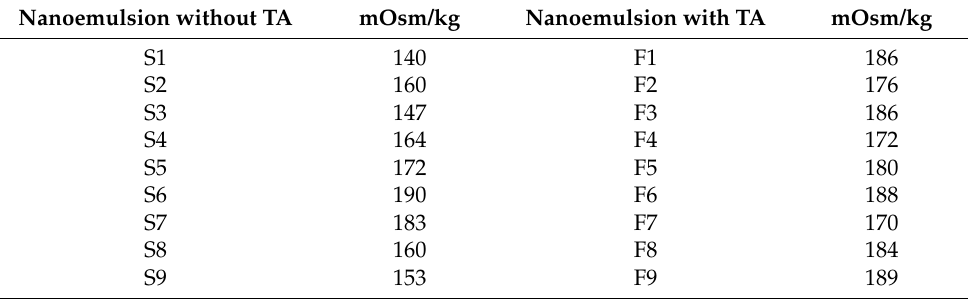
Table 4. Osmolality of nanoemulsions with and without TA.